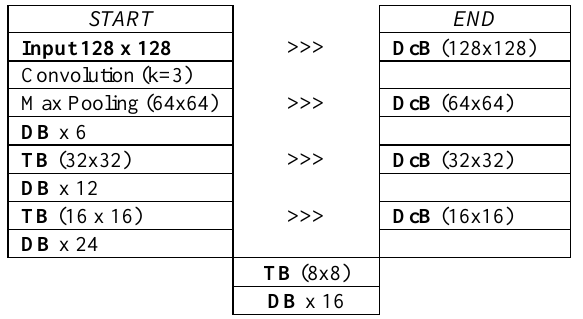
Figure 5. Network architecture to perform image segmentation. Denseblock as DB , transitional block as TB and decoder block as DcB . Within brackets the feature map size of a given block. The indicated convolutions are always followed by batch normalization and relu. >>> indicates input to the